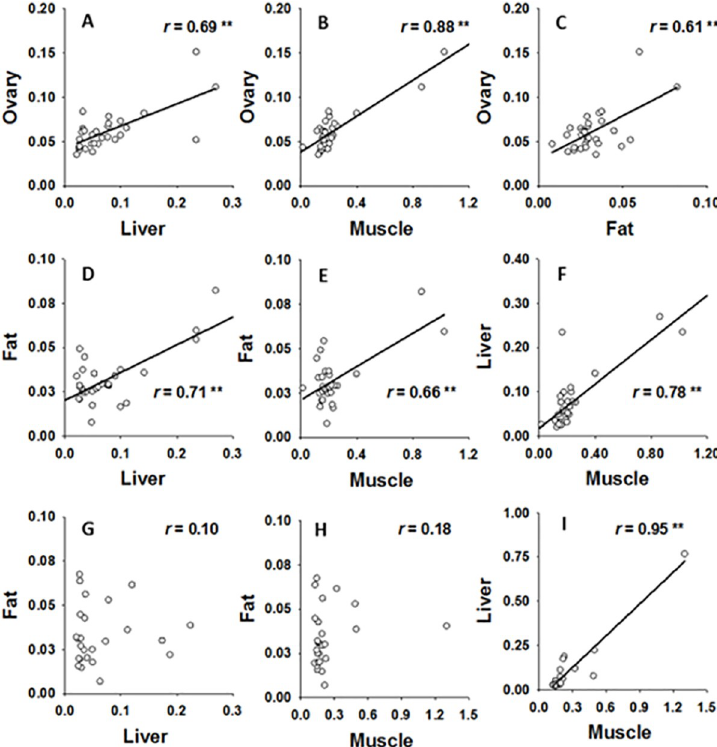
Fig 5. Relationships in THg concentrations among lionfish tissues. Relationship among THg (all axes are shown in μ g g -1 dw) in various tissues in female (Panels A-F, n = 31) and male lionfish (Panels G-I, n = 26). Coefficients from Pearson canonical correlation analysis ( r ) are inset within each Panel, significant correlations at α = 0.05 with sequential Bonferroni correction are noted by asterisks ( �� ).